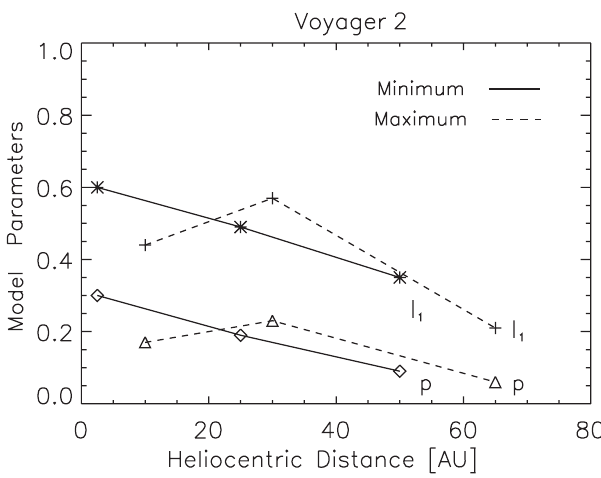
Fig. 4. Evolution of the parameters of the two-scale ( l 1 ,l 2 ) weighted (parameter p ) Cantor set model as a function of the heliospheric distance during solar maximum (dashed lines) and solar minimum (continuous lines).